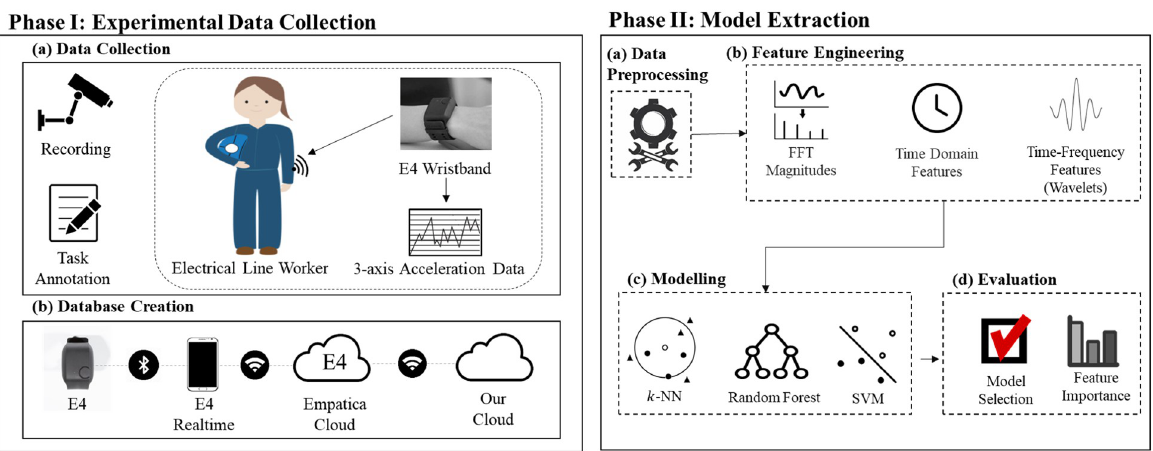
Fig 3. An overview of activity recognition framework for acquiring, preprocessing, and analyzing acceleration data.